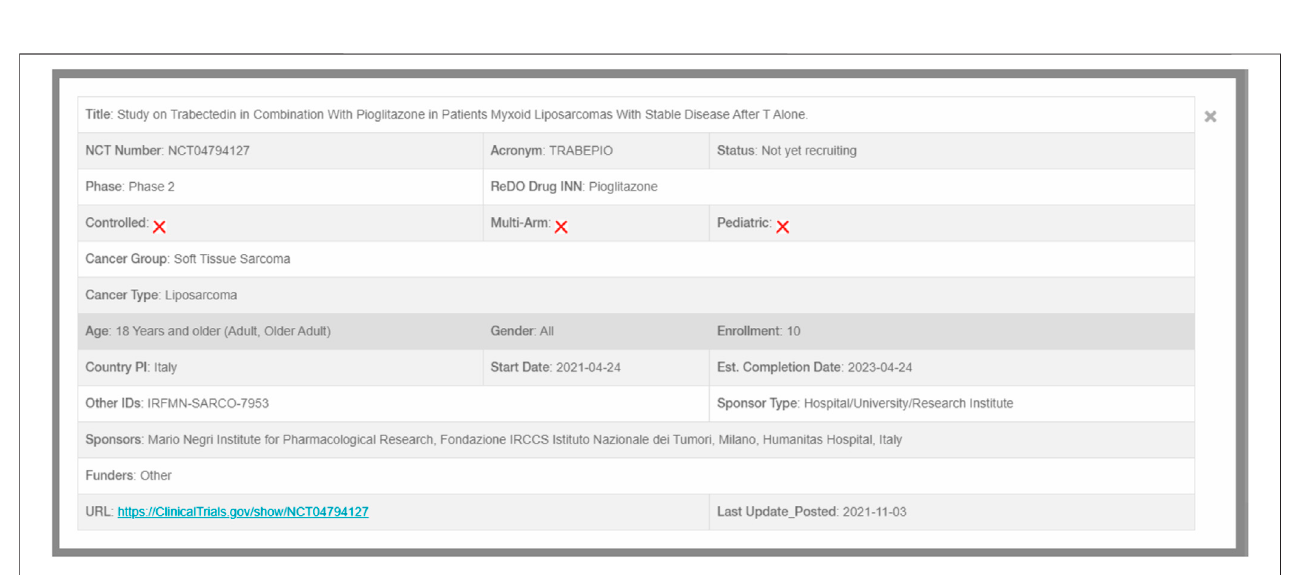
FIGURE 2 | Individual trial